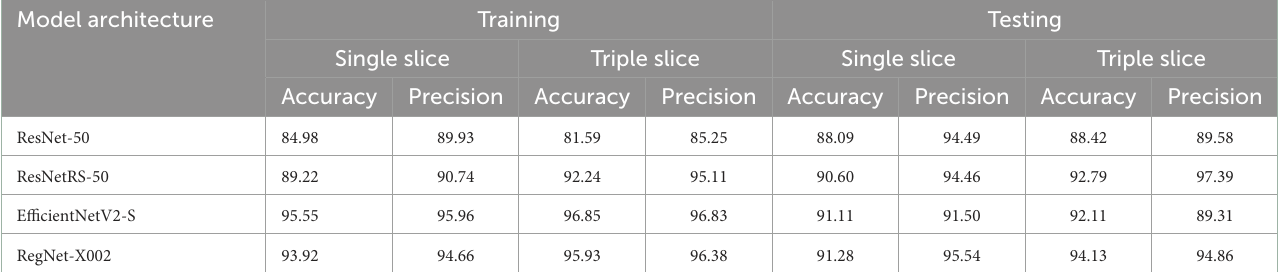
TABLE 2 Accuracy and precision of ROC curve results for ResNet-50, ResNetRS-50, EfficientNetV2-S, and RegNet-X002. Accuracy and precision were calculated from the ROC AUC curves of all four regression models. Accuracy refers to the percentage of correctly classified instances while precision refers to the percentage of positive predictions that were truly